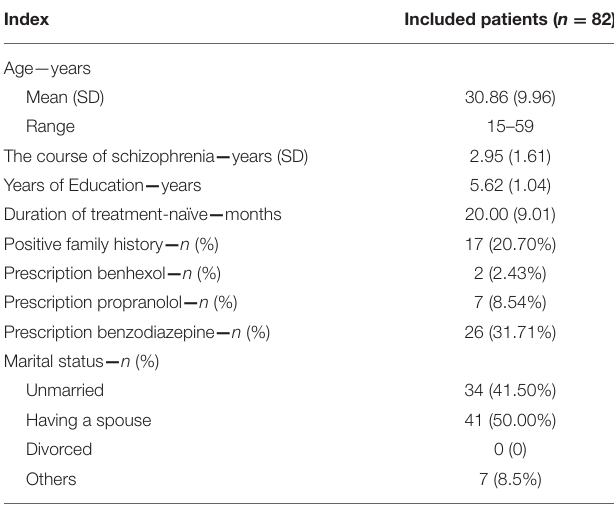
TABLE 1 | The general clinical characteristics of the included patients.